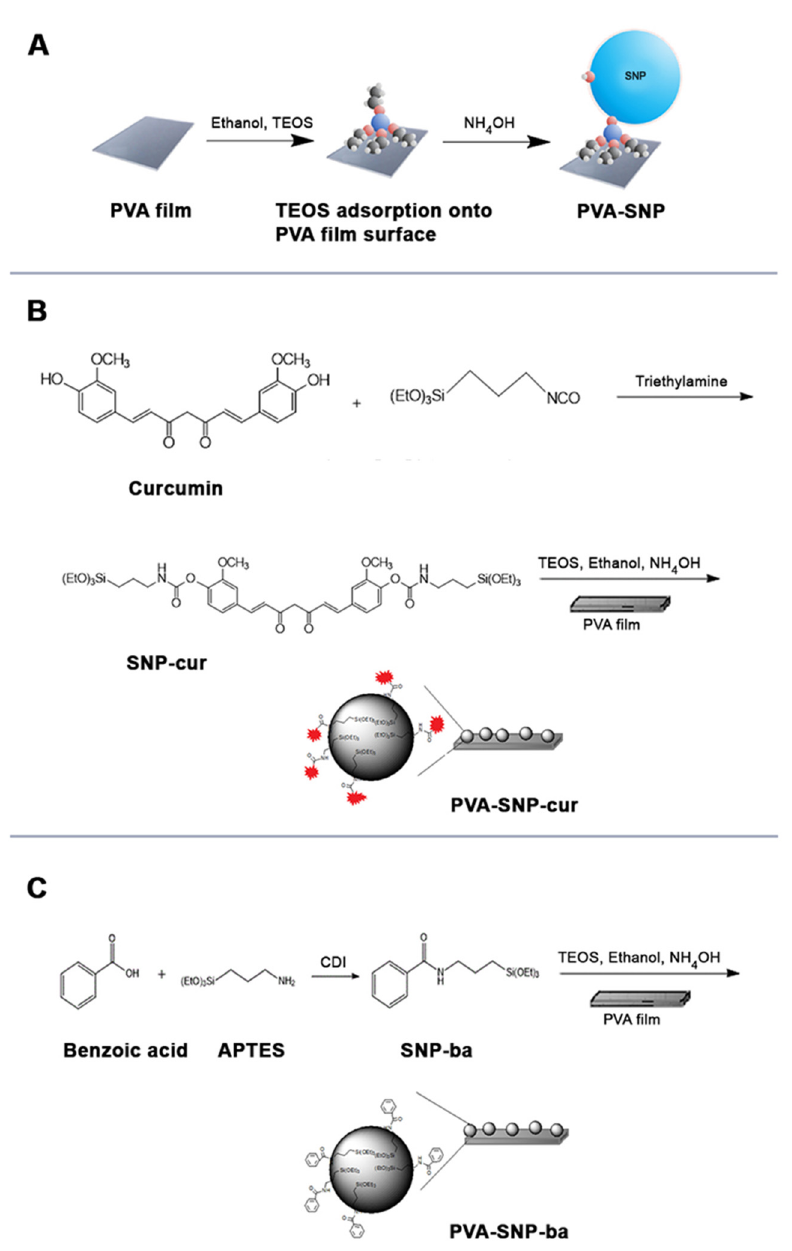
Figure 1. ( A ) In situ grafting of tetraethyl orthosilicate (TEOS) on PVA to form PVA-SNP films. ( B ) Preparation of curcumin-bearing silica precursor and in situ grafting on PVA to form PVA-SNP-cur films. ( C ) Preparation of benzoic acid-bearing silica precursors and in situ grafting on PVA to form PVA-SNP-ba films.